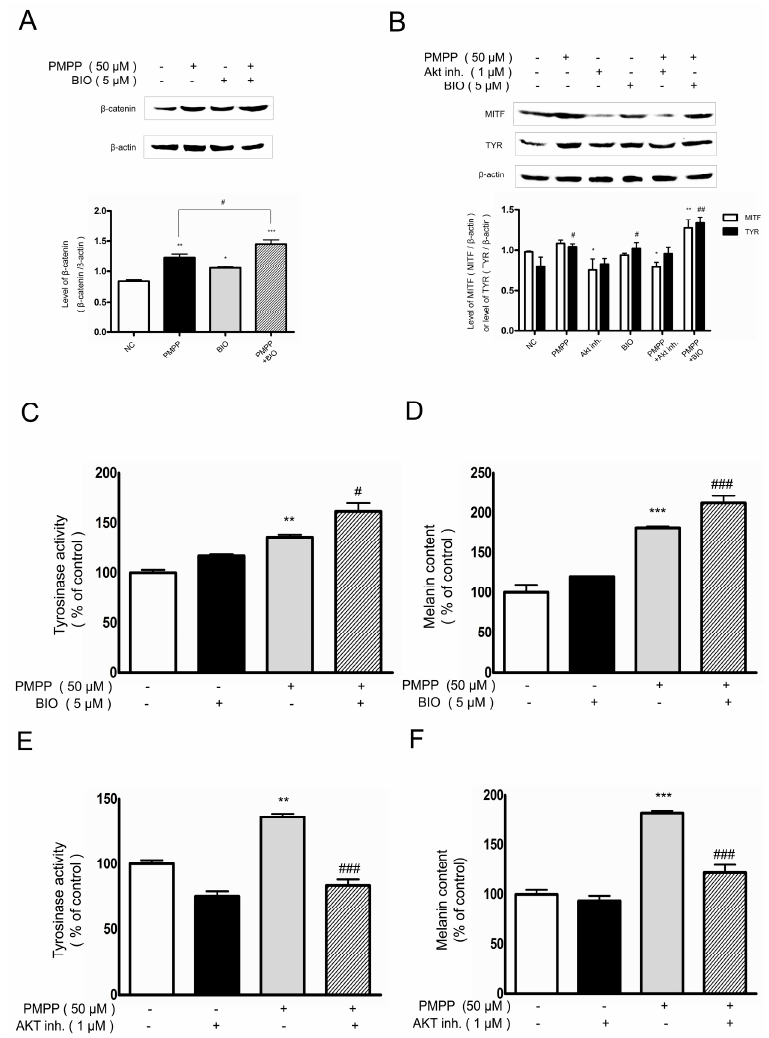
Figure 7. Effects of PMPP on β -catenin, Microphthalmia-associated transcription factor (MITF), tyrosinase (TYR) protein expression and TYR activity, and melanin content in B16 cells treated with GSK3 β or Akt inhibitor. ( A ) The GSK3 β inhibitor increased PMPP-induced β -catenin expression. β -catenin was detected in B16 cells pre-treated with or without BIO (5 µ M) and incubated with PMPP (50 µ M) or not. Data from the densitometric scanning of band intensities obtained from three separate experiments are presented as means ± SD. * p < 0.05, ** p < 0.01, *** p < 0.001 versus untreated cells, # p < 0.05 versus PMPP alone; ( B ) Effects of inhibitors on PMPP-induced MITF and TYR expression. The expressions of MITF and TYR were determined by Western blot in B16 cells treated with PMPP or not in the presence or absence of BIO (5 µ M) or Akt inhibitor IV (1 µ M) for 48 h. Data from the densitometric scanning of band intensities obtained from three separate experiments are presented as means ± SD. * p < 0.05, ** p < 0.01 versus MITF control, # p < 0.05, ## p < 0.01 versus TYR control. GSK3 β inhibitor enhanced PMPP-induced TYR activity ( C ) and melanin content ( D ). The Akt inhibitor suppressed PMPP-induced TYR activity ( E ) and melanin content ( F ). B16 cells pre-incubated with inhibitors (BIO 5 µ M, AKT inhibitor IV 1 µ M) were further incubated with 50 µ M PMPP, then followed by an additional incubation for 24 h (tyrosinase activity) or 48 h (melanin content). Each percentage value in the treated cells was calculated with respect to that in the untreated cells. Values are expressed as the mean ± SD of three separate experiments. ** p < 0.01, *** p < 0.001 compared with control; # p < 0.05, ### p < 0.001 compared with PMPP stimulation.